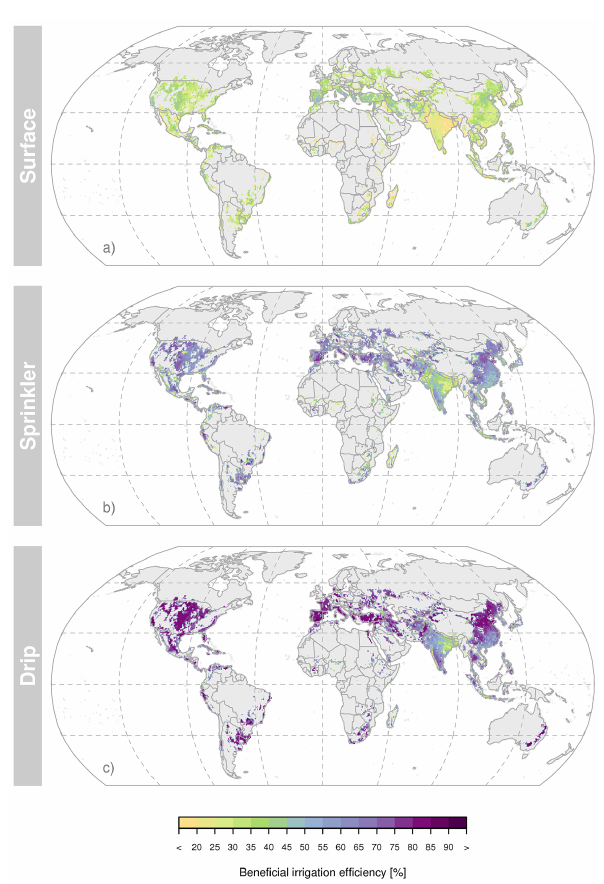
Figure 5. Global patterns of beneficial irrigation efficiency ( E b , ra- tio of transpired and diverted water) for each irrigation system – (a) surface, (b) sprinkler, and (c) drip, calculated as area-weighted mean over CFTs (excl. “others” and pastures). This figure is based on theoretical scenarios, in which each system is respectively as- sumed to be applied on the entire irrigated